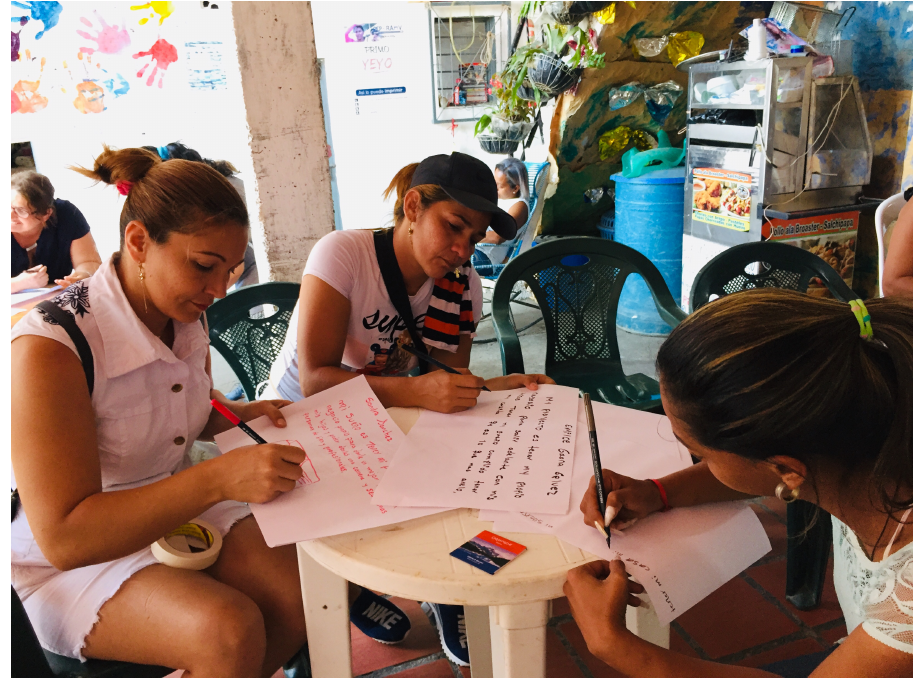
Figure 3. Research participants in Colombia writing and drawing mental maps describing their mobility experiences and their future hopes during a participatory Minga workshop.